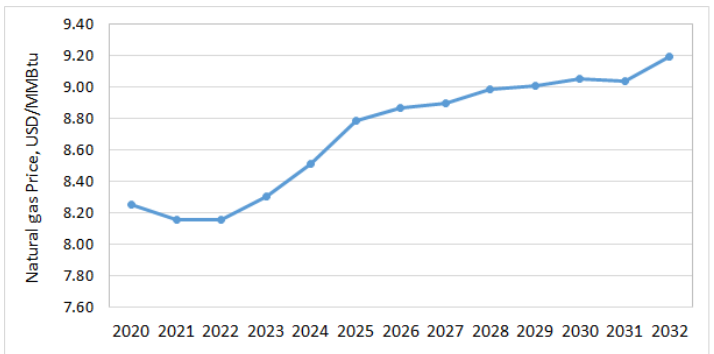
Figure 5. Liquefied natural gas (LNG) Price projection [36].